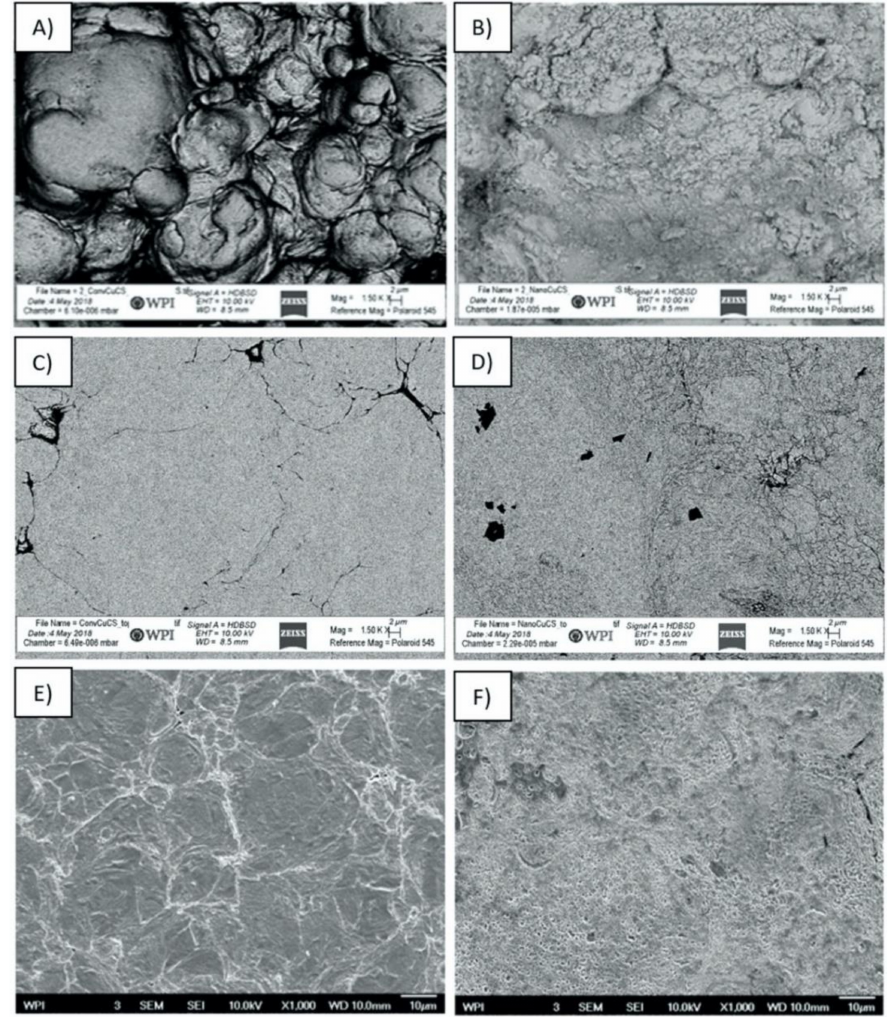
Figure 14. SEM micrographs are shown herein. HDBS micrographs of the orthogonal orientation of consolidated conventional Cu is given in ( A ), while the nanostructured Cu is given in ( B ), the polished conventional Cu is given in ( C ), and the polished nanostructured Cu is given in ( D ). Field emission SEM micrographs are shown for the orthogonal orientation of the polished and etched consolidated conventional Cu in ( E ) and the nanostructured Cu coating in ( F